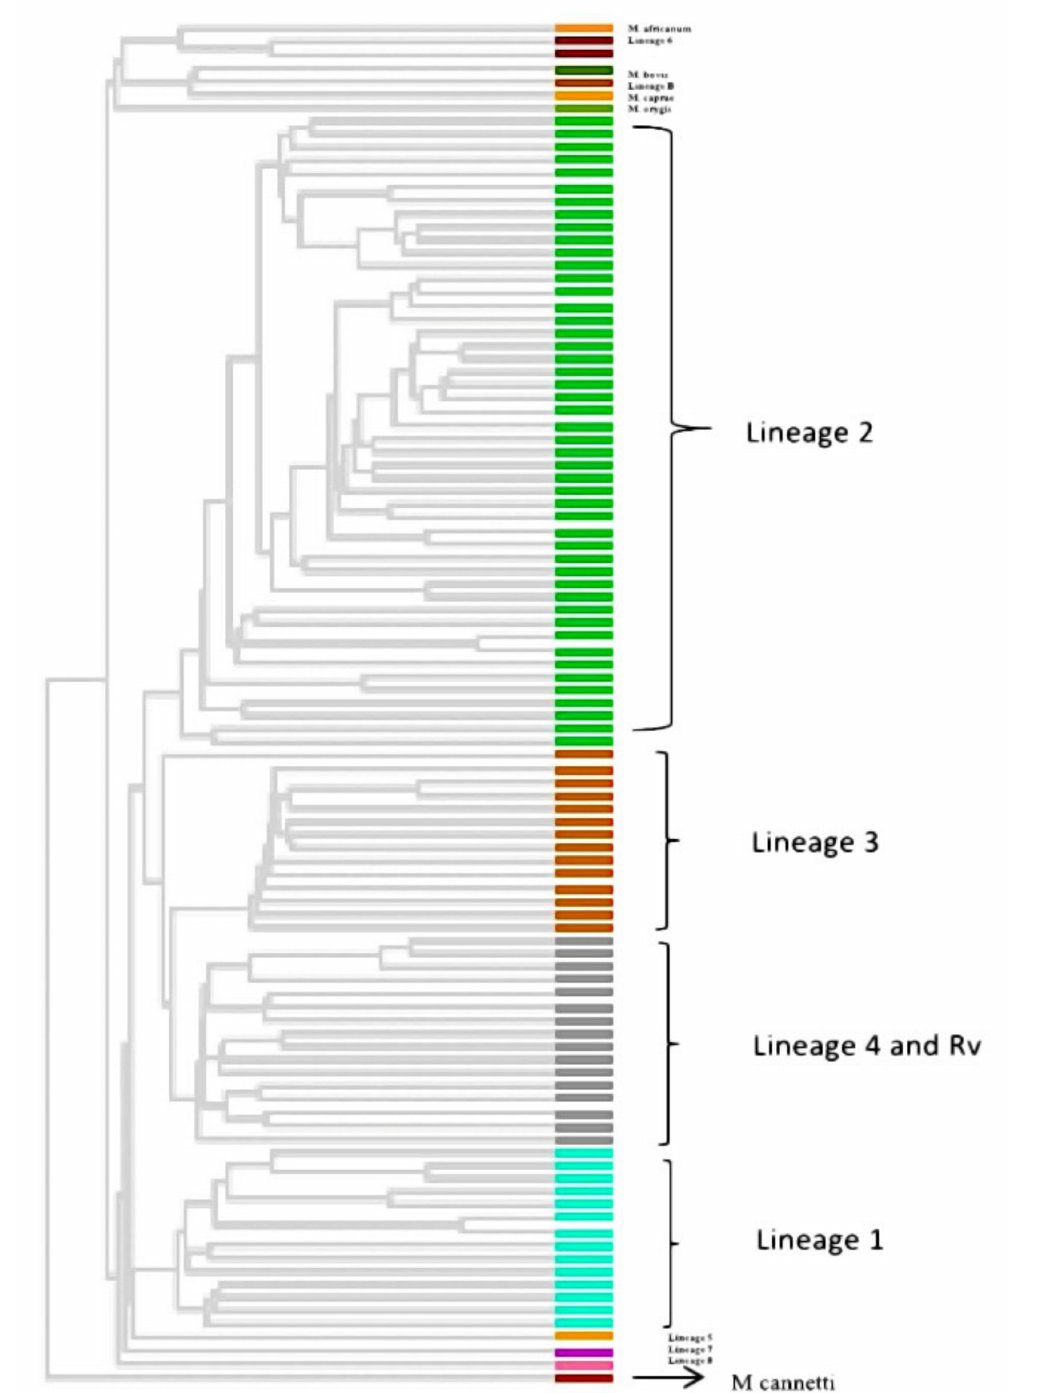
Figure 3. Phylogenetic analysis (UPGMA tree) based on cgMLST association of 104 genomes (65 iso- lates under this study and 33 lineage-defined genomes and 6 reference genomes of MTBC complex viz. Mycobacterium africanum , Mycobacterium bovis , Mycobacterium caprae , Mycobacterium orygis , M. tu- berculosis and Mycobacterium cannettii ). Mycobacterium cannettii was used to root the tree. Each lineage is shown with different